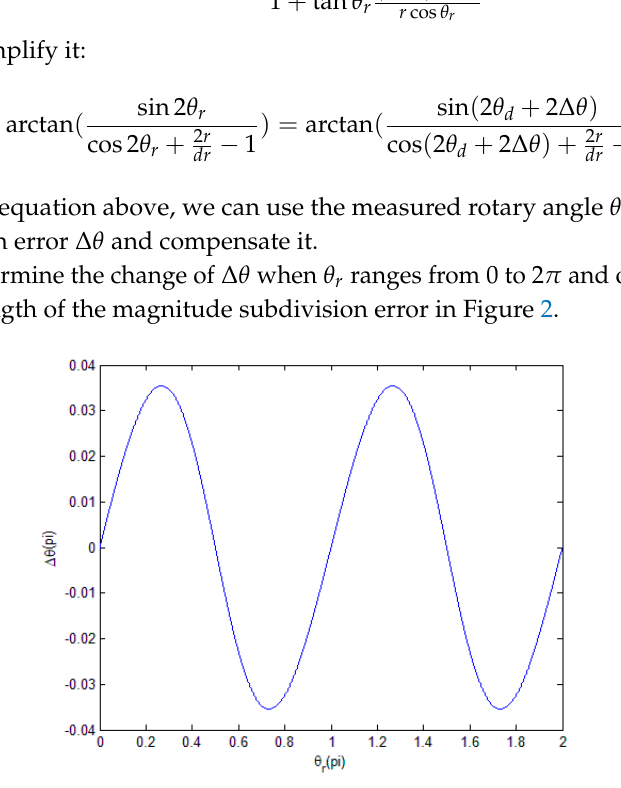
θ . Figure 2. Distribution law of ∆ θ M in one period of θ r r